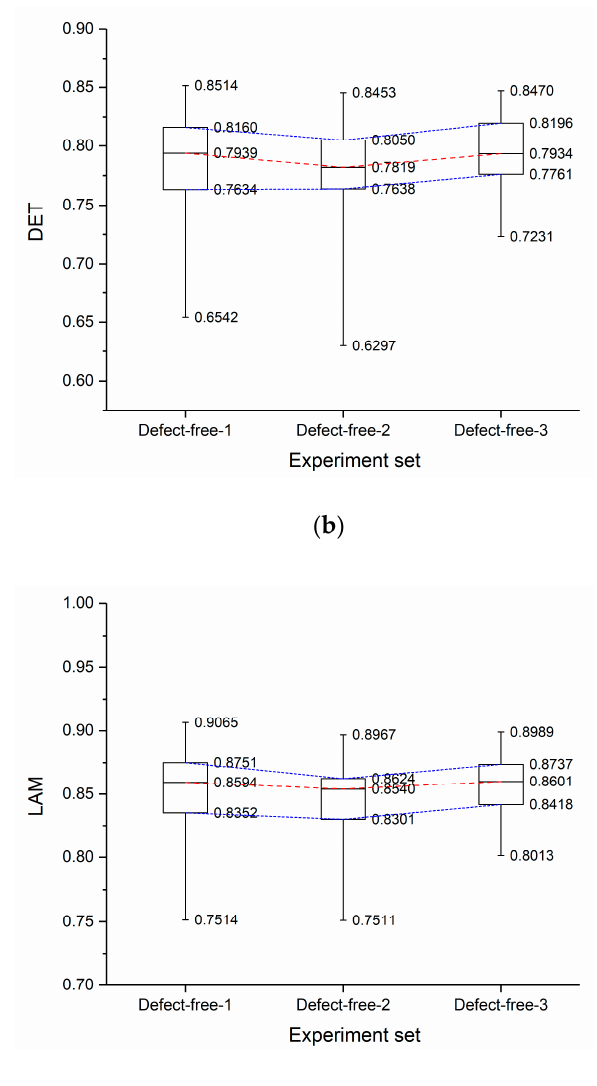
Figure 10. Statistical results of recurrence quantification analysis (RQA) variables of defect-free areas; ( a ) RR; ( b ) percent determinism (DET); and, ( c ) laminarity (LAM).